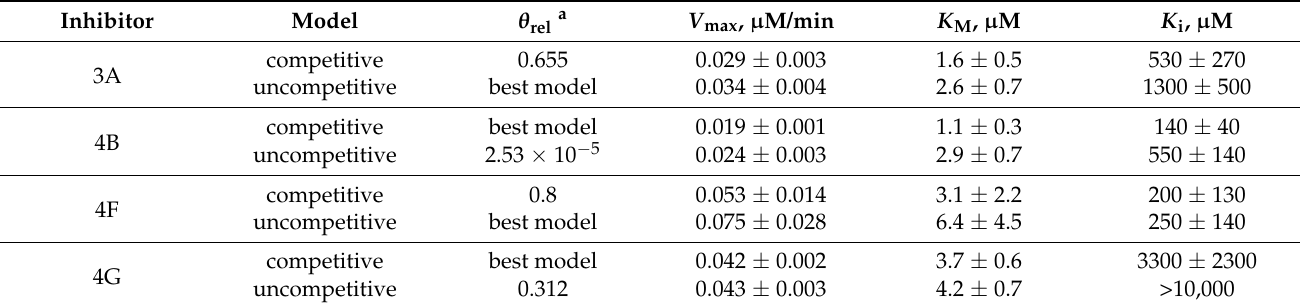
Figure 3. The mode of UNG inhibition. ( a ) Cleavage of the substrate (1 µ M) by hUNG at different concentrations of compound 4B; ( b ) cleavage by hUNG at different concentrations of the substrate and compound 4B plotted in double reciprocal coordinates. Table 1. Kinetic constants for substrate cleavage by hUNG in the presence of various